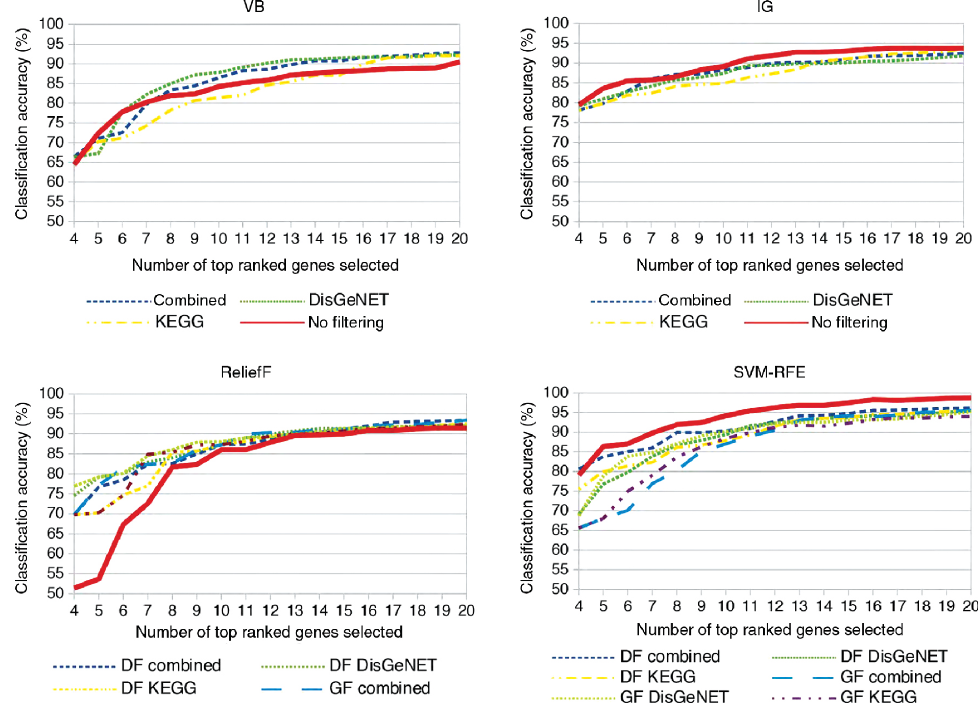
Figure 7: Classification accuracies on dataset II for the respective traditional gene selection approaches and their combi- nation with external knowledge: Variance-based (VB), Information Gain (IG), ReliefF, and SVM-RFE.